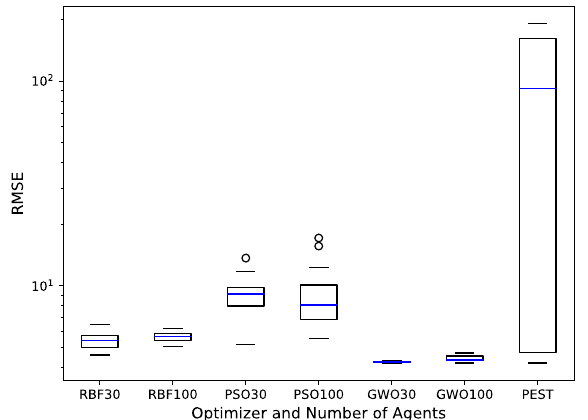
Figure 5. Box plot of the root mean squared error (RMSE) produced by 15 runs of each optimizer and PEST.